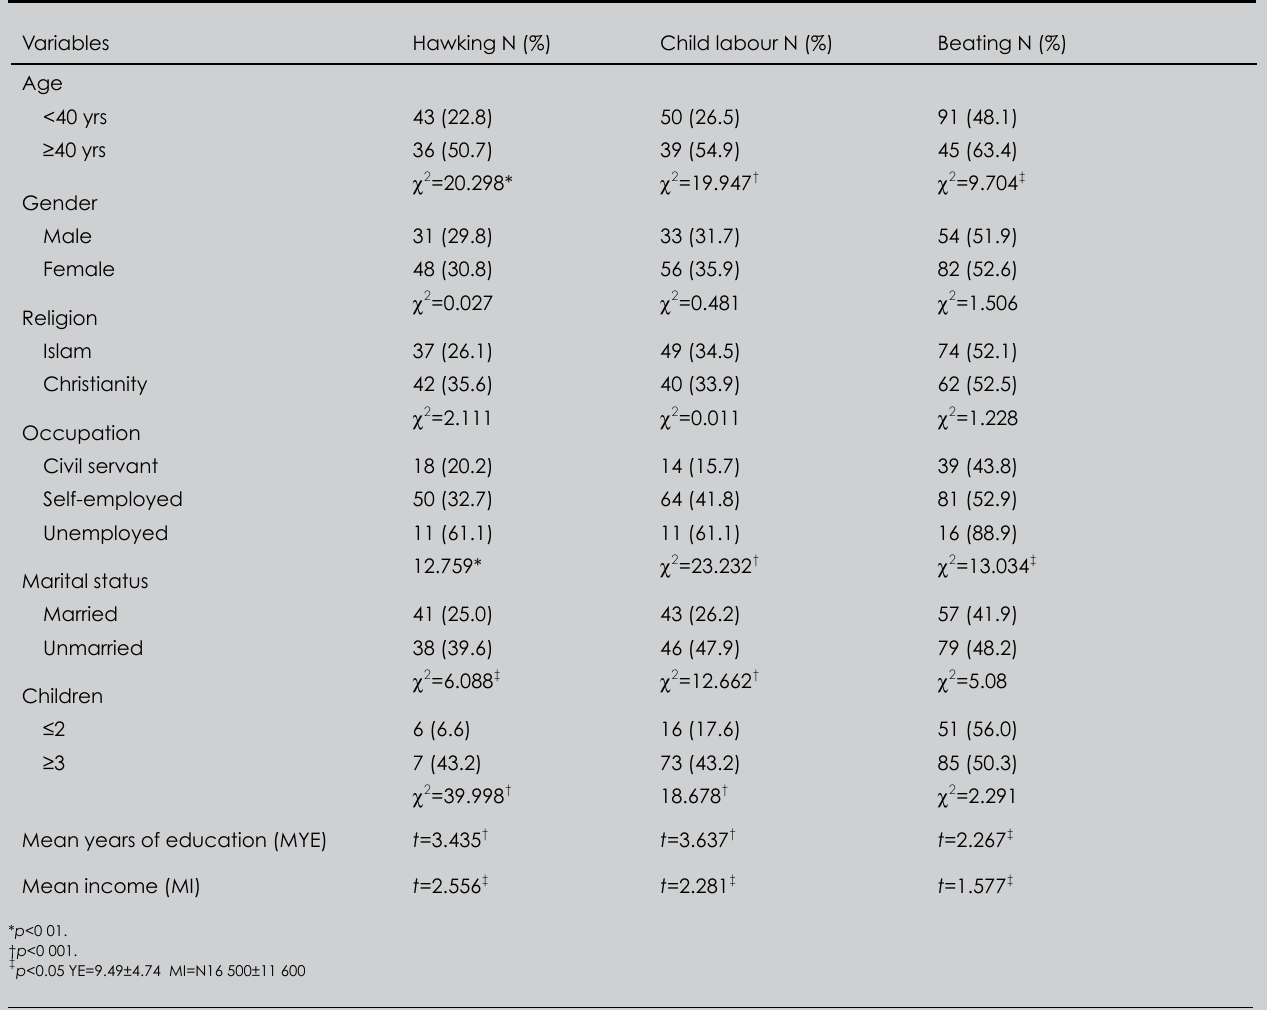
Table II. Socio-demographic variables and some forms of child abuse